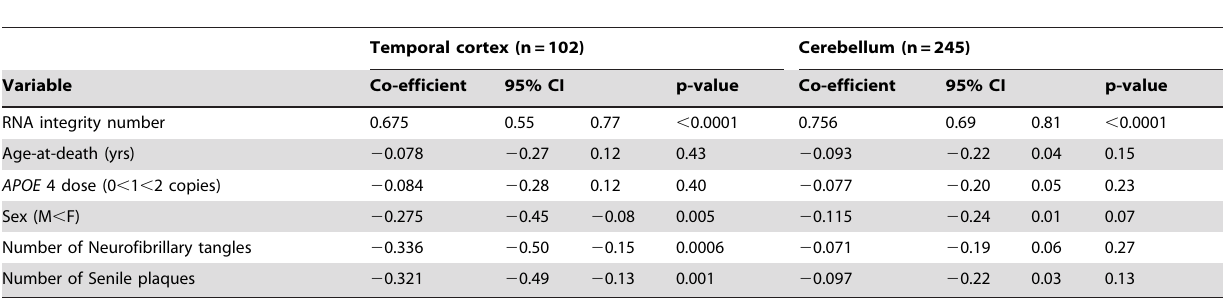
Table 9. Increased GAB2 mRNA expression is associated with decreased AD pathology in temporal